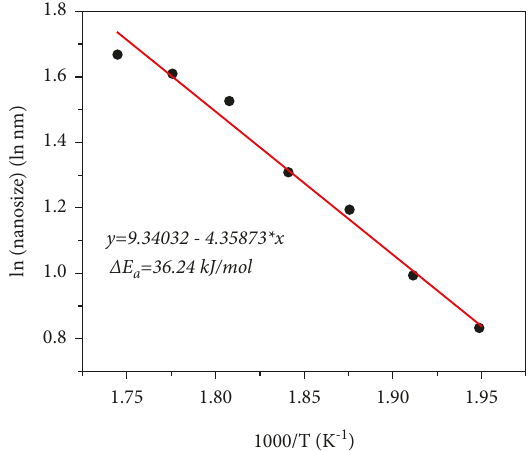
Figure 7: Arrhenius plot of in (D) against the reciprocal of temperature for ZnS nanocrystal growth in the oleylamine: dodecanethiol (1:1) solvent mixture. The nanocrystallite sizes were obtained from the XRD patterns at different reaction temperatures (Figure 3). (The correlation between particle sizes determined by XRD and UV-Vis is shown in Figure